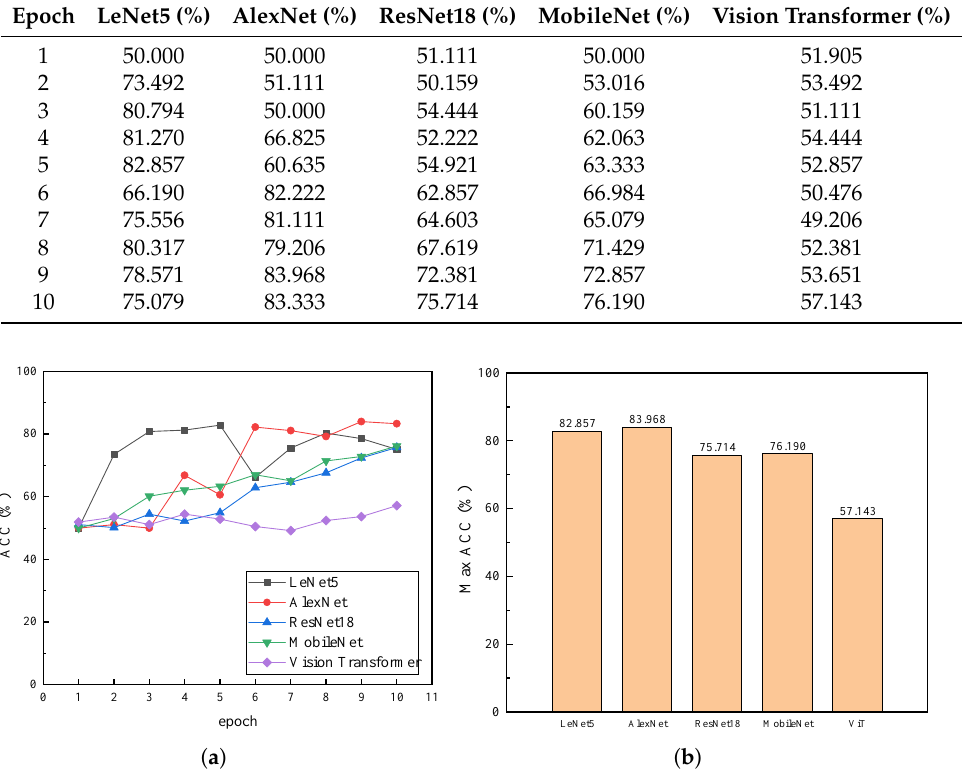
Table 9. Accuracy of pneumonia identification by each model after data augmentation and before GPU loading.